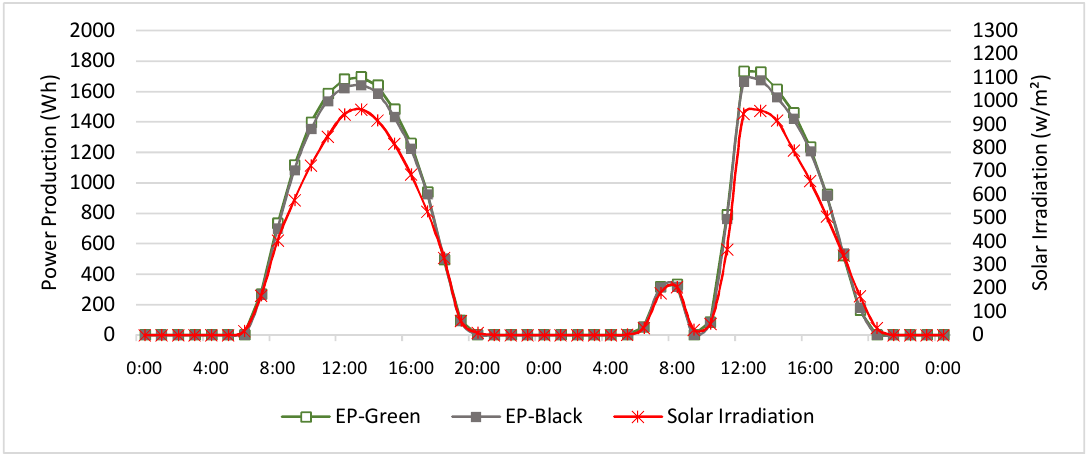
EP-Black was 1666 Wh. The energy production profiles show maximum temperature differences of about 54 Wh and 67 Wh at the peak production for the first day and the second day, respectively. This translates to differences of 3.3% and 4% between EP-Green and EP-Black in peak energy The UST-Green and the UST-Black reached a peak temperature of 63.3 ◦ C and 66.6 ◦ C, as evidenced in production values. The solar irradiation and energy production profiles show similar patterns and the data. the peak solar irradiation values were 964 W/m 2 on the first day and 959 W/m 2 on the second day.